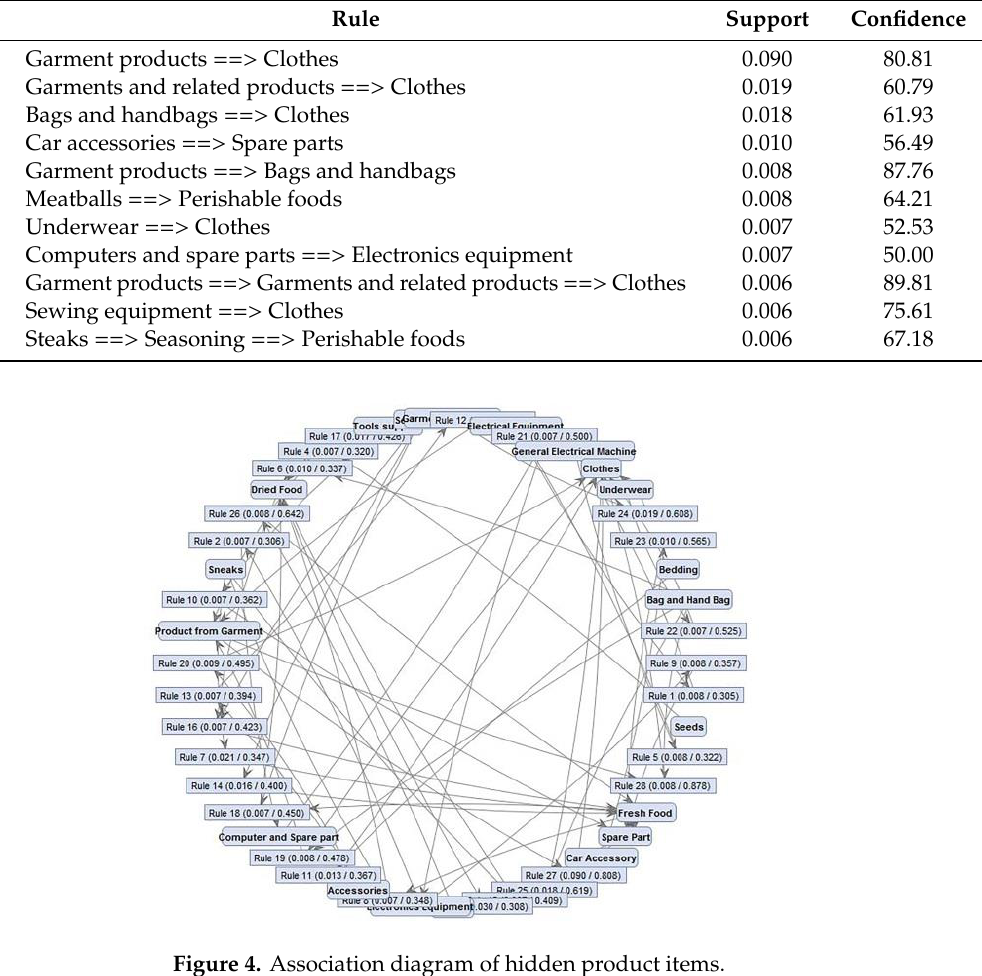
Figure 4. Association diagram of hidden product items.